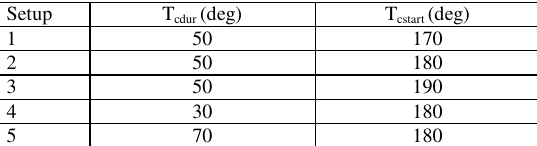
Table 11. Variable parameters for engine cycle simulations Setup